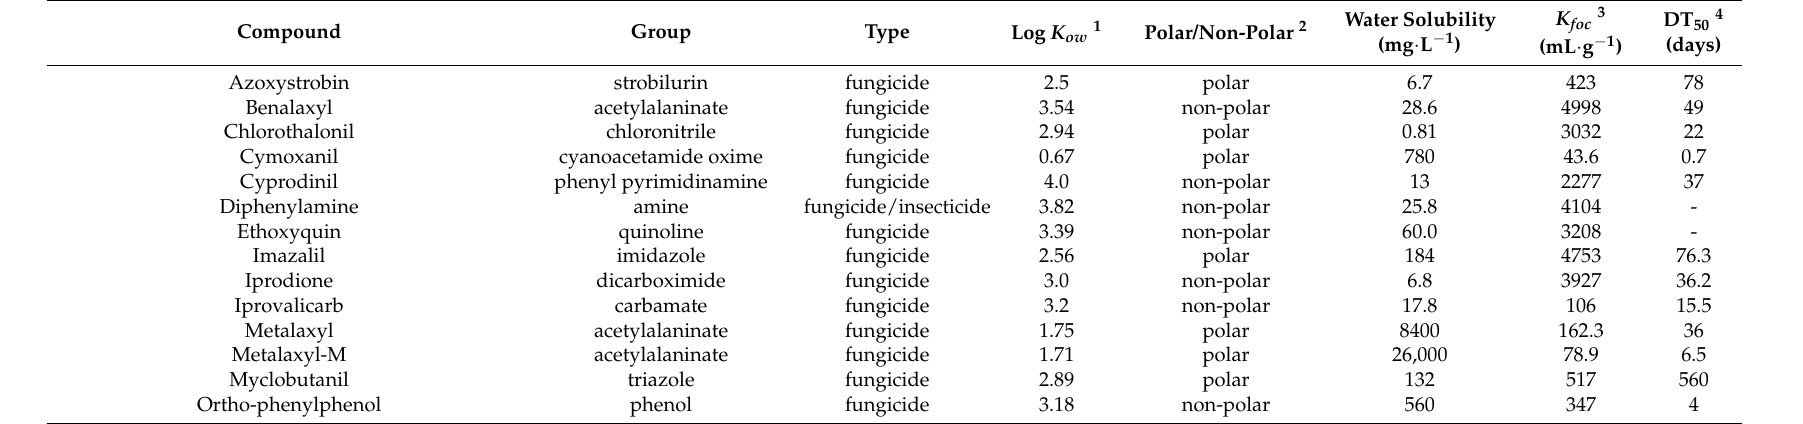
Table 2. Characteristics of pesticides studied. Data taken from PPDB